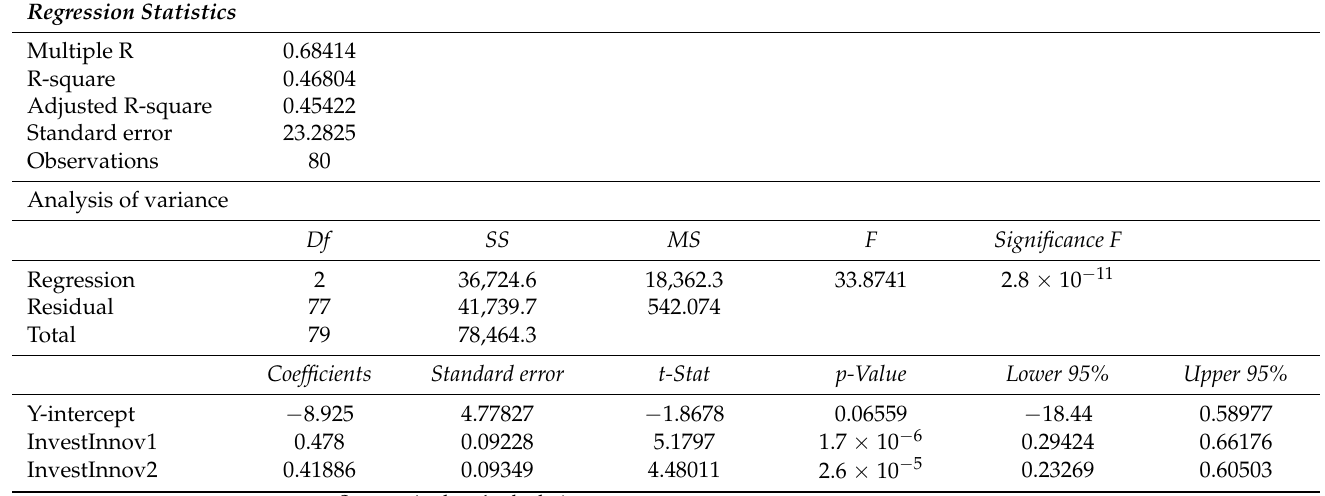
Table A9. Regression statistics of the dependence of Frisk 4 on investments in innovation (InvestIn- nov).